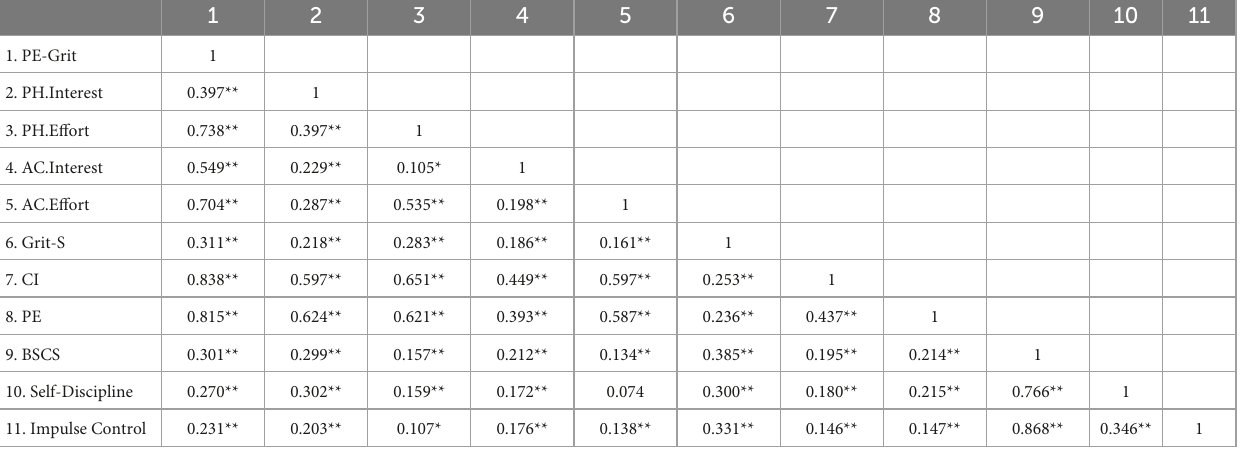
TABLE 4 Correlation coefficients between the PE-Grit, Grit-S , and BSCS